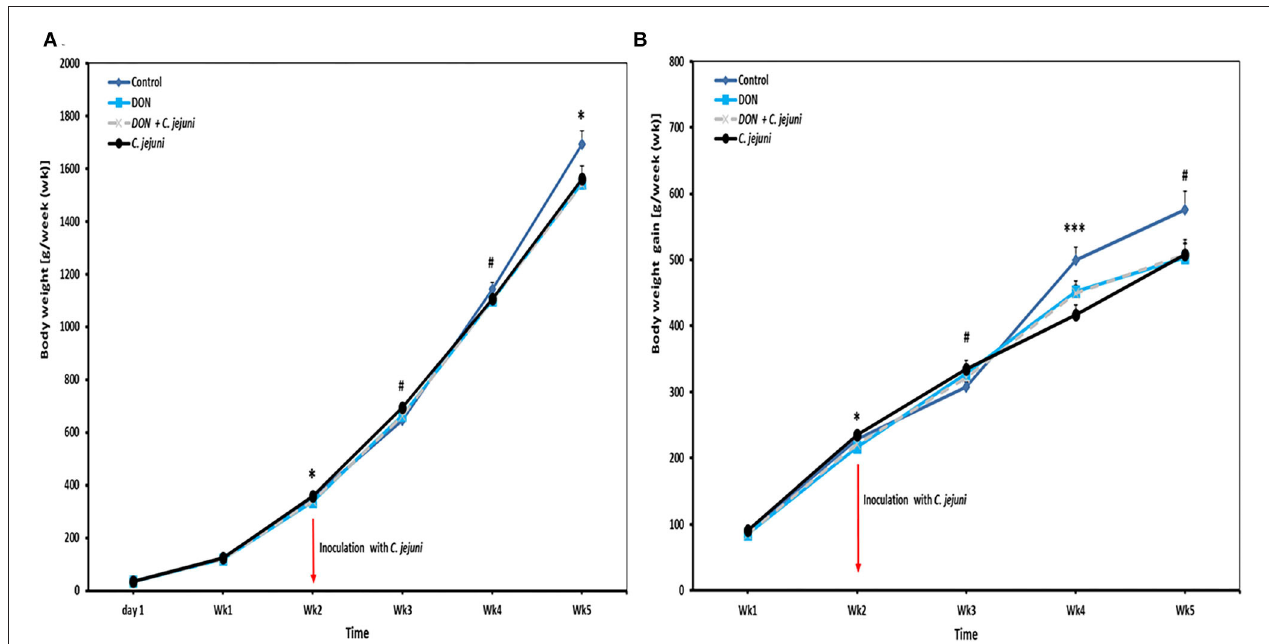
FIGURE 1 | Effect of DON and/or C. jejuni exposure on (A) body weight (BW) and (B) body weight gain (BWG). Results are presented as mean and standard error of mean (SEM). Asterisks mark differences with # P ≤ 0.1, * P ≤ 0.05, or *** P ≤ 0.001.